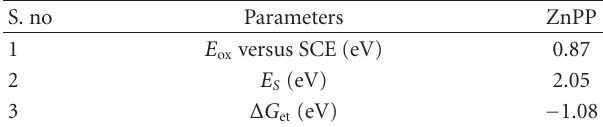
Table 1: Photophysical properties of